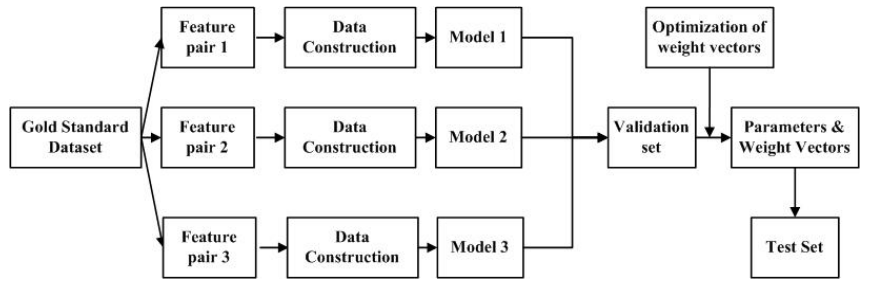
Figure 2. The flowchart of the Ensemble-MFP